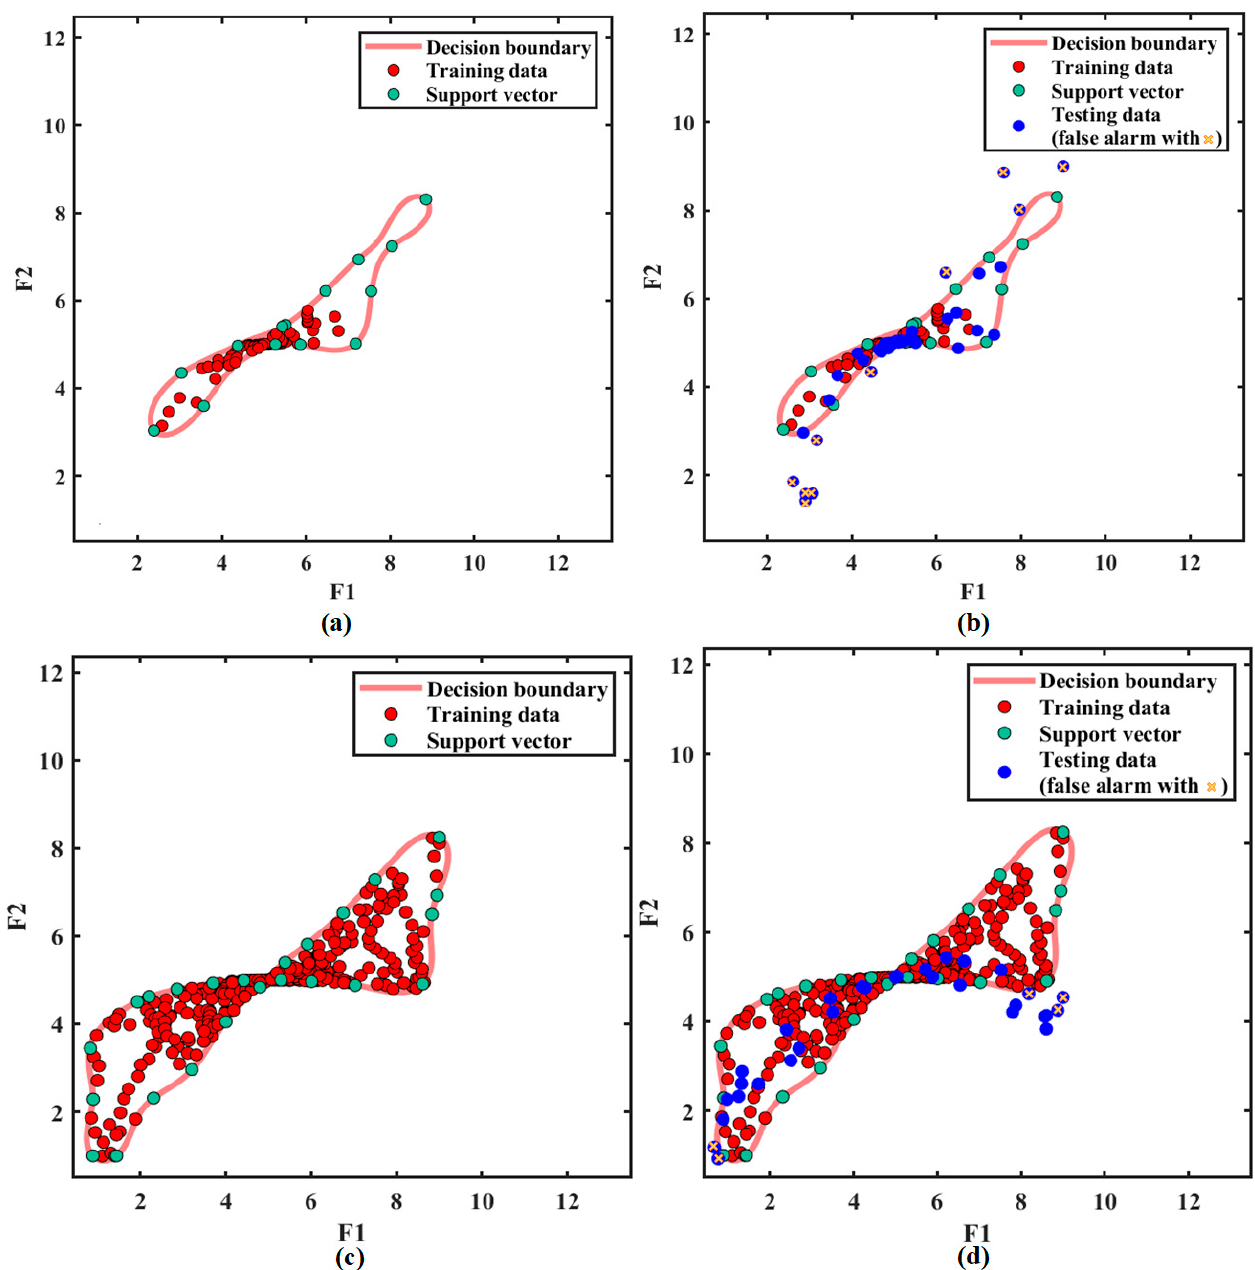
Figure 9. Classification results: ( a ) Training result without VMD processing; ( b ) Testing result without VMD processing; ( c ) Training result with VMD processing; ( d ) Testing result with VMD processing.